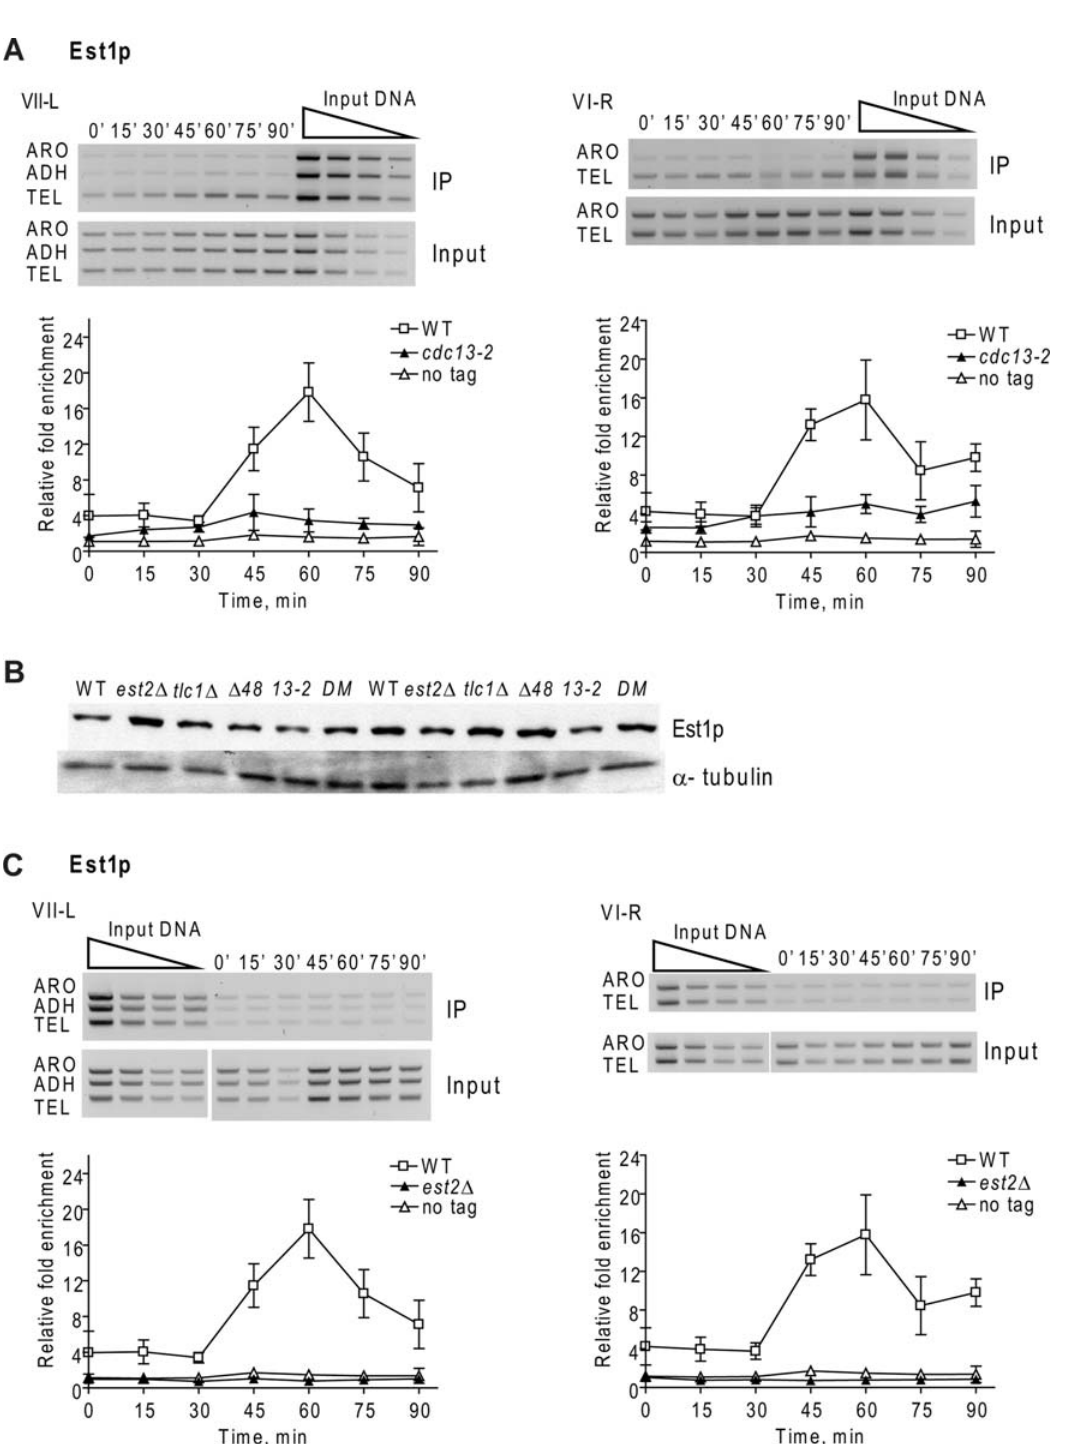
Figure 2. Est1p telomere binding is greatly reduced in synchronous cdc13-2 cells and eliminated in est2 D cells. Methods and symbols are as described in the Figure 1 legend except that cells expressed Est1-Myc. A. Est1p binding to VII-L (left) and VI-R (right) telomeres in synchronous cdc13-2 (black triangles) versus WT (white squares), or untagged (white triangles) cells. Est1p binding to the VII-L telomere was significantly higher in cdc13-2 cells than in the no-tag control at times of peak Est1p binding (P values ranged from 0.0003 at 60 min to 0.035 at 90 min). Est1p binding to the VI-R telomere was significantly different from the no-tag control at all time points (P values ranged from 0.0006 at 60 min to 0.0065 at 90 min.). B. Western analyses of Est1p-Myc versus a -tubulin levels in extracts from WT and mutant strains. The lanes labeled D 48 are from different tlc1 D 48 colonies; 13-2 is cdc13-2 ; DM is double mutant tlc1 D 48 cdc13-2 . C. Est1p binding to VII-L (left) and VI-R (right) telomeres in synchronous est2 D (black triangles) versus WT (white squares), or untagged (white triangles) cells. Est1p binding to the VII-L and VI-R telomeres in est2 D cells was modestly higher than the no-tag control only at 45 (P=0.04 VII-L; 0.013, VI-R) and 60 min (P=0.04, VII-L; 0.03, VI-R).